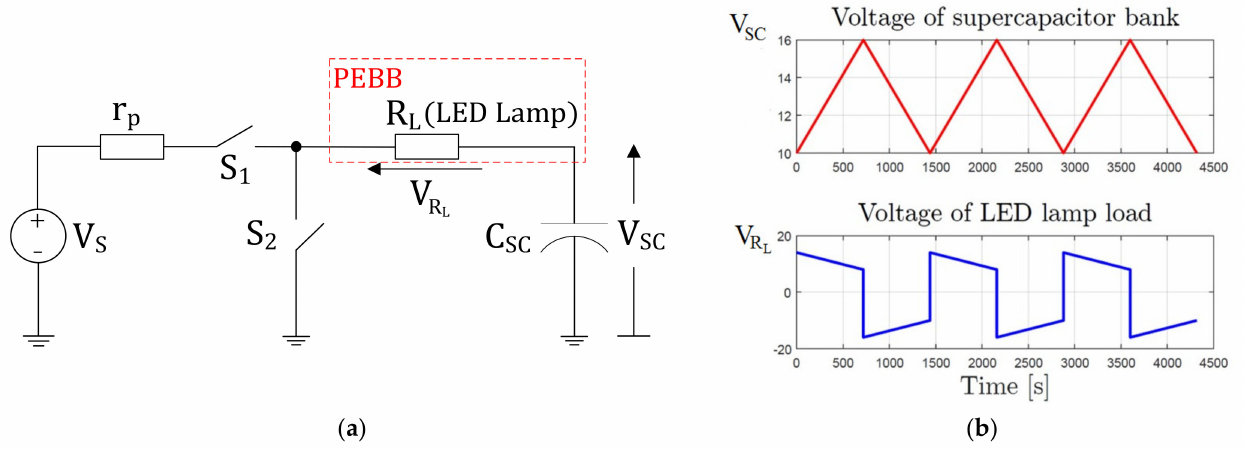
Figure 10. Concept of the proposed SCALED converter: ( a ) modified RC charging loop with LED lamp; ( b ) simulated voltage waveforms for SC bank and LED lamp